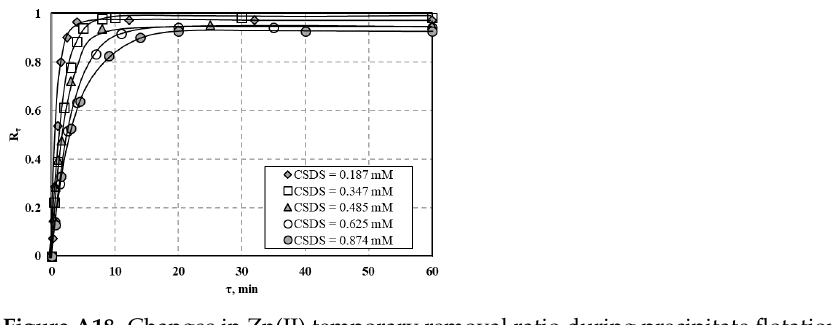
Figure A18. Changes in Zn(II) temporary removal ratio during precipitate flotation from solution containing Al(III), Cu(II), and Zn(II) mixture—effect of collector concentration (c 0 = 2 mmol dm − 3 , pH = 8.7, u G = 1.51 mm s − 1 ).